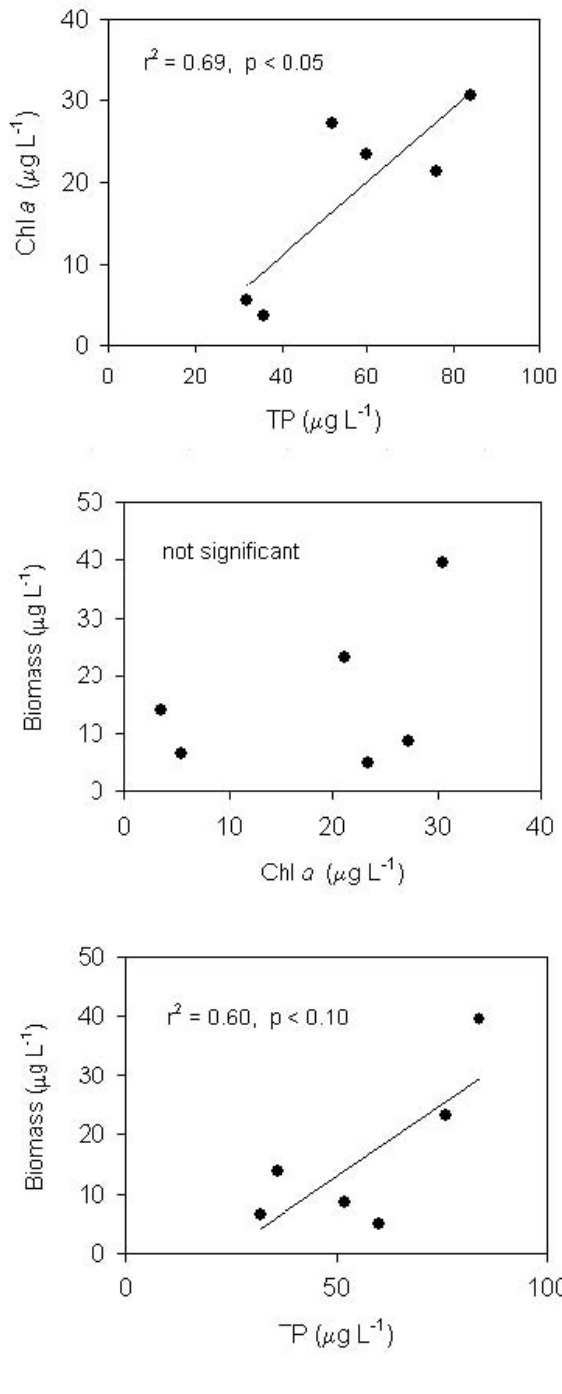
FIGURE 9. Relationships between lake-average (mean of all observations) epilimnetic concentrations of chlorophyll a (Chl α ), total phosphorus (TP), and macro-zooplankton community biomass. Least-squares regression models are included where p values are